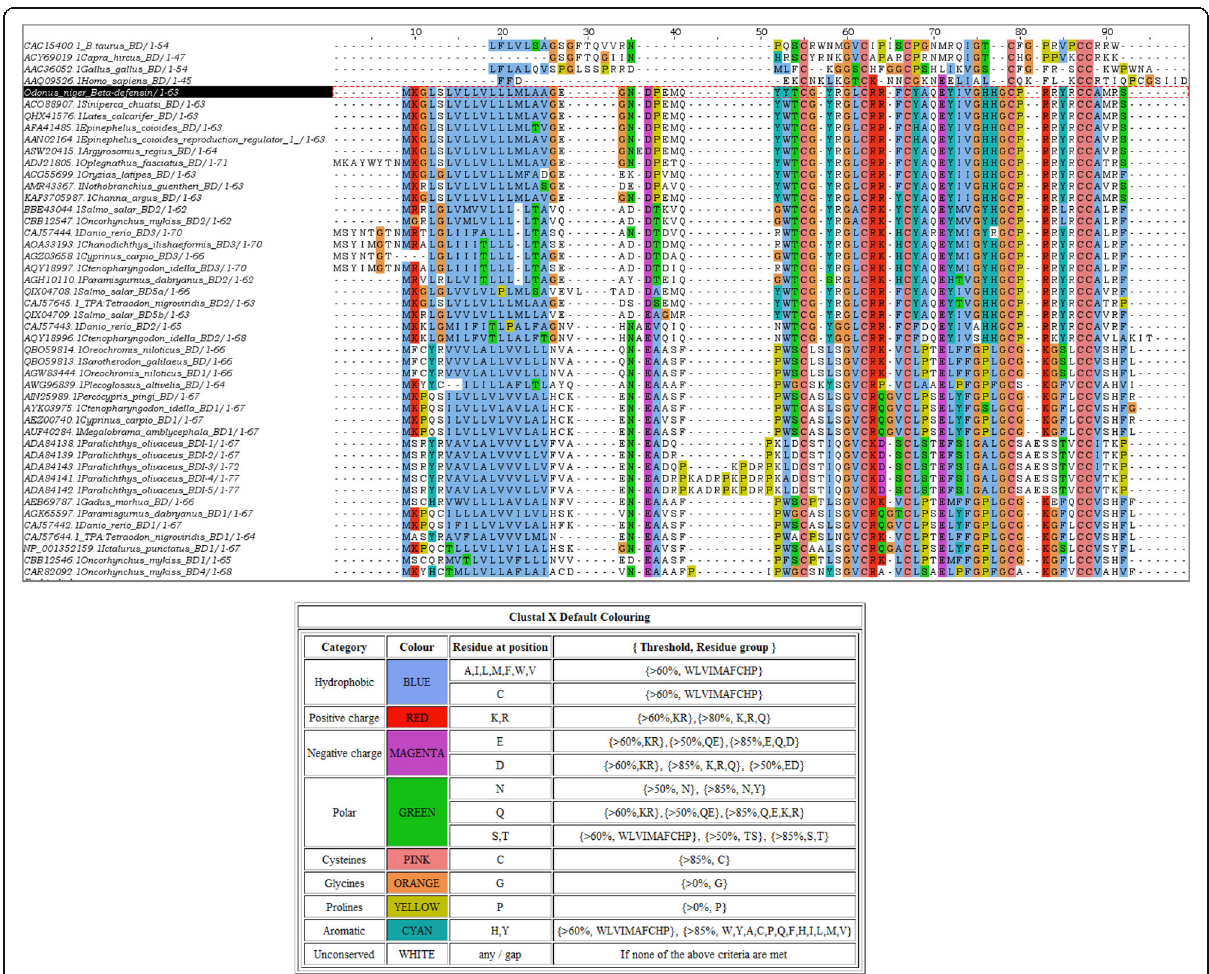
Fig. 3 MAFFT alignment of Odonus niger β -defensin ( On -Def) was done against other β -defensins using the Jalview Version 2.11.1.0 workbench. On -Def peptide sequence is highlighted. ClustalX colour scheme was applied to the alignment to get a general view of any conservation pattern in the amino acid profile across different